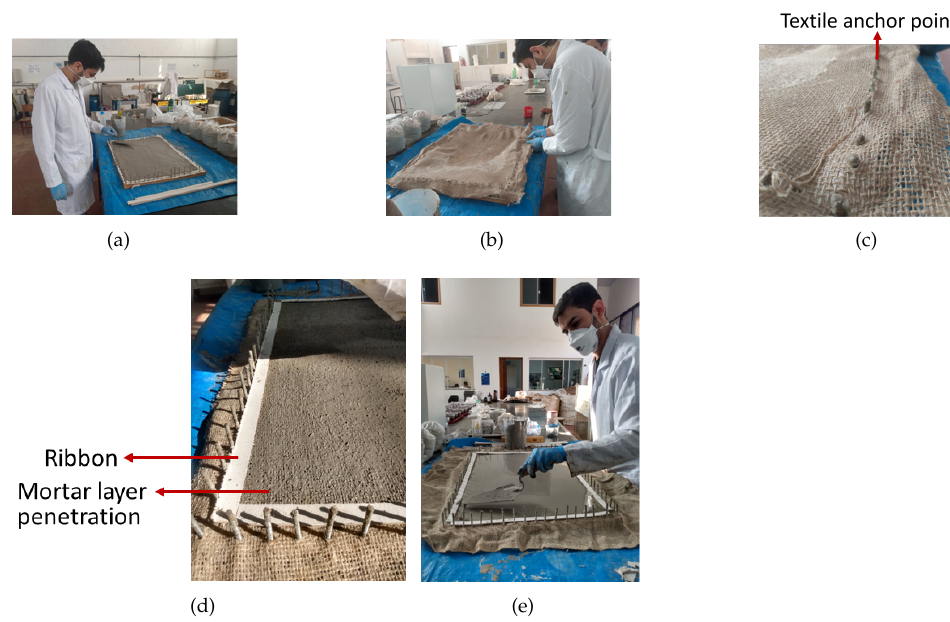
Figure 5. Composite molding: ( a ) first layer of mortar, ( b , c ) fixation of jute fabric, ( d ) mortar layer penetration, and ( e ) last layer of mortar ( e